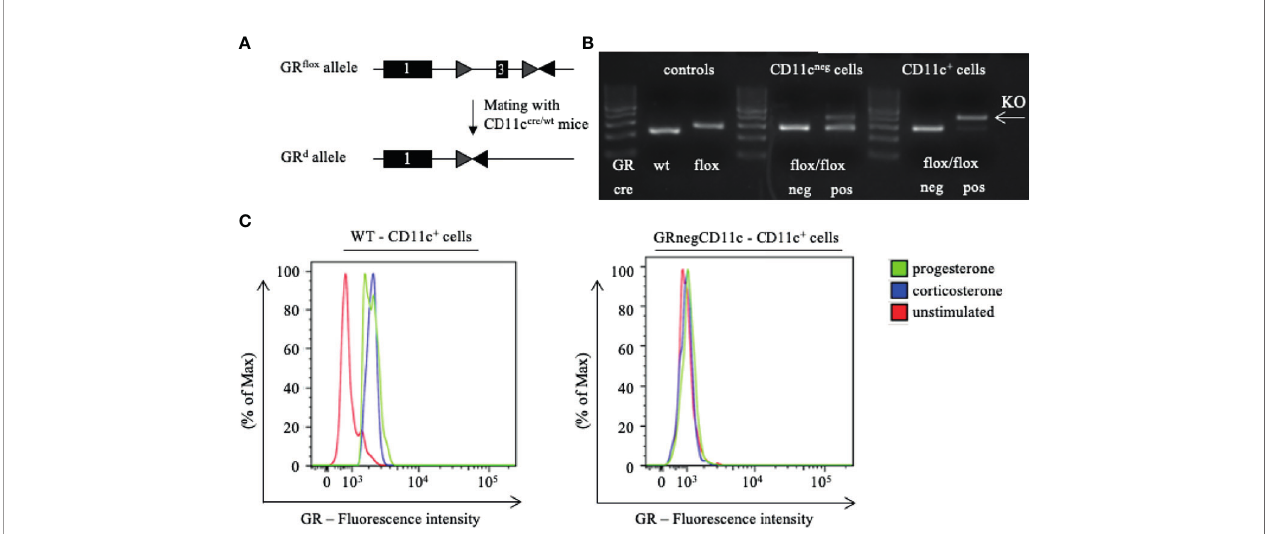
FIGURE 1 | Generation of a selective knockout (KO) of the glucocorticoid receptor (GR) on CD11c dendritic cells (DCs). (A) GR fl ox/ fl ox mice were crossed with CD11c cre/wt transgenic mice resulting in recombination of the GR fl ox allele to a GR null allele (GRd) on CD11c + cells. (B) The selective KO of the GR on CD11c + cells was con fi rmed on DNA level. PCR amplicons were visualized using agarose gel electrophoresis and band sizes were 225 bp for the wildtype allele, 275 bp for the fl oxed allele, and 390 bp for the KO allele, respectively. (C) The selective KO of the GR on CD11c + DCs harvested from WT and GRnegCD11c mice was con fi rmed on protein level by means of fl ow cytometry. Cells were preincubated with either progesterone or corticosterone to enable GR staining. Fluorescence intensity histogram con fi rms the presence (left) or absence (right) of the GR,